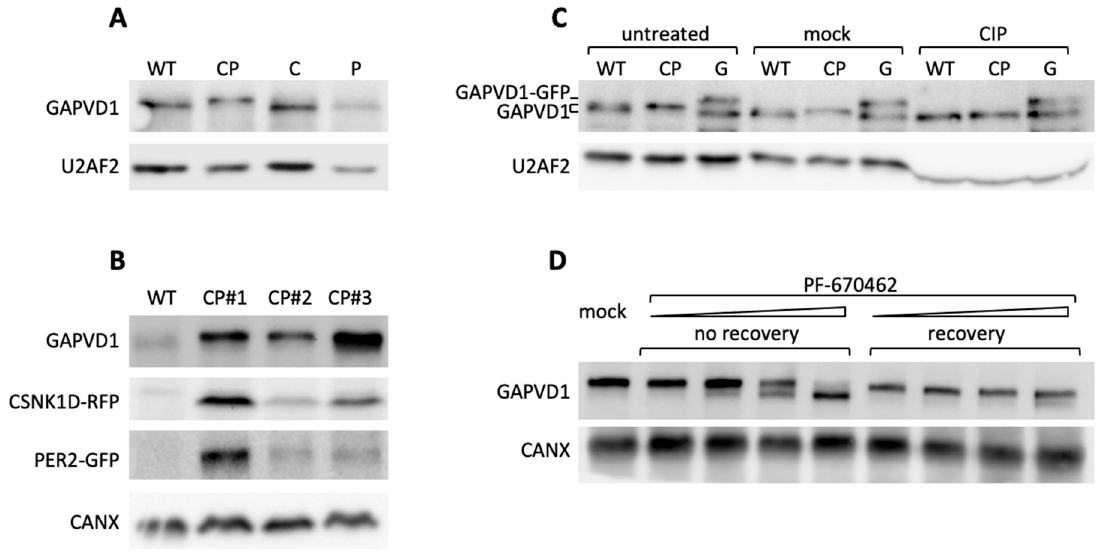
Figure 4. CSNK1D-dependent GAPVD1 phosphorylation is regulated by PER2 ( A ) Western blot analysis of GAPVD1 in HT1080 wild type cells, HT1080 cells overexpressing CSNK1D-GFP (C), PER2-GFP (P) or PER2-GFP and CSNK1D-RFP (CP) were analyzed with an antibody against human GAPVD1; ( B ) Clonal CP cells (CP#1–3) were analyzed with antibodies against GAPVD1, RFP, and GFP; ( C ) HT1080 wild type, and CP cells were analyzed untreated, mock-treated (phosphatase buffer, no calf intestinal phosphatase (CIP)) or CIP-treated (phosphatase buffer and CIP) and analyzed with an antibody against GAPVD1. HT1080 cells overexpressing GAPVD1-GFP were included as size marker; ( D ) CP cells were treated with increasing amounts (20 nM, 200 nM, 2 µM, 20 µM) of PF670462 for 18 h. Cells were harvested directly after treatment or allowed to recover for 24 h after withdrawal of the drug and analyzed with an antibody against GAPVD1. Antibodies against U2 small nuclear RNA auxiliary factor 2 (U2AF2) and Calnexin (CANX) were used as a control for equal loading.